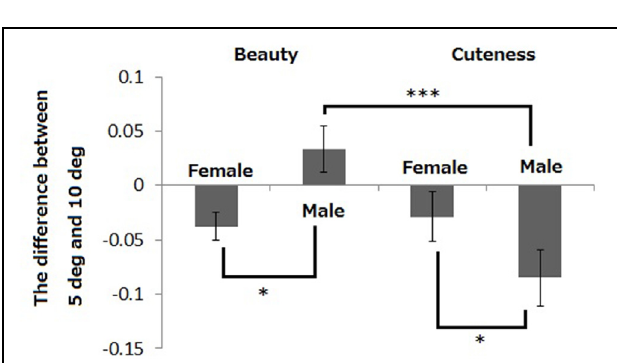
FIGURE 4 | The difference in accuracy rates between 5 ◦ and 10 ◦ . The error bars show the SEM across stimulus faces. ∗∗∗ p < 0.001, ∗ p <